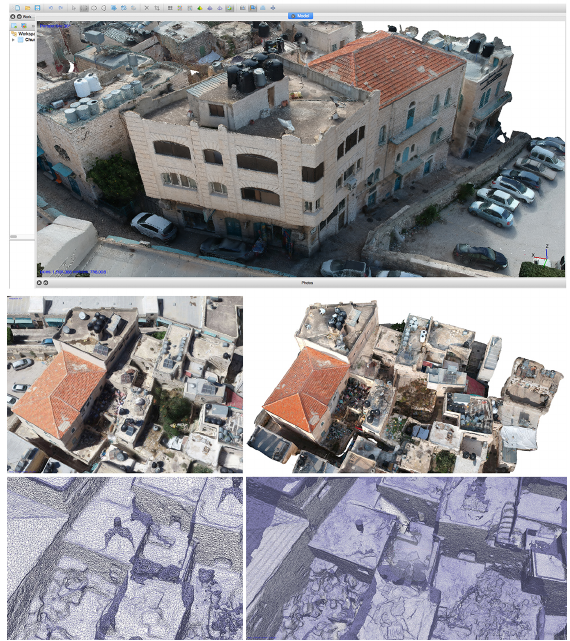
Figure 11: Above, the Agisoft Photoscan visualization of the 3D model from Spark. Below on the left, the model obtained with Phantom 4 Pro compared, on the right, with the model obtained from Spark, that presents more definition on geometrical details.